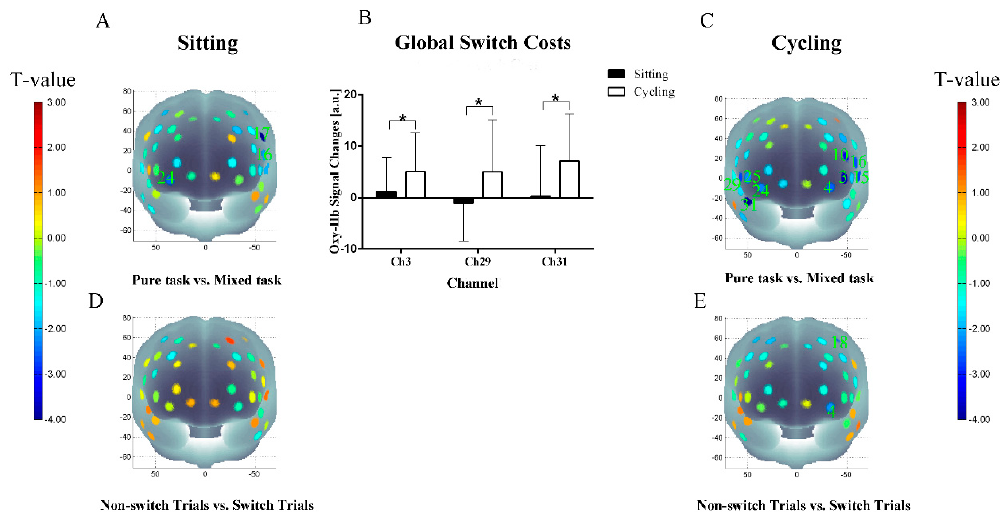
Figure 5. fNIRS results of task-switching ( A ) t-map of oxy-Hb concentrations in the sitting condition, pure task vs. mixed task; ( B ) Oxy-Hb changes related to the global switch costs; ( C ) t-map of oxy-Hb concentrations in the cycling condition, pure task vs. mixed task; ( D ) t-map of oxy-Hb concentrations in the sitting condition, non-switch trials vs. switch trials; ( E ) t-map of oxy-Hb concentrations in the cycling condition, non-switch trials vs. switch trials. Data are expressed as mean ± SD. * indicates FDR-corrected P <